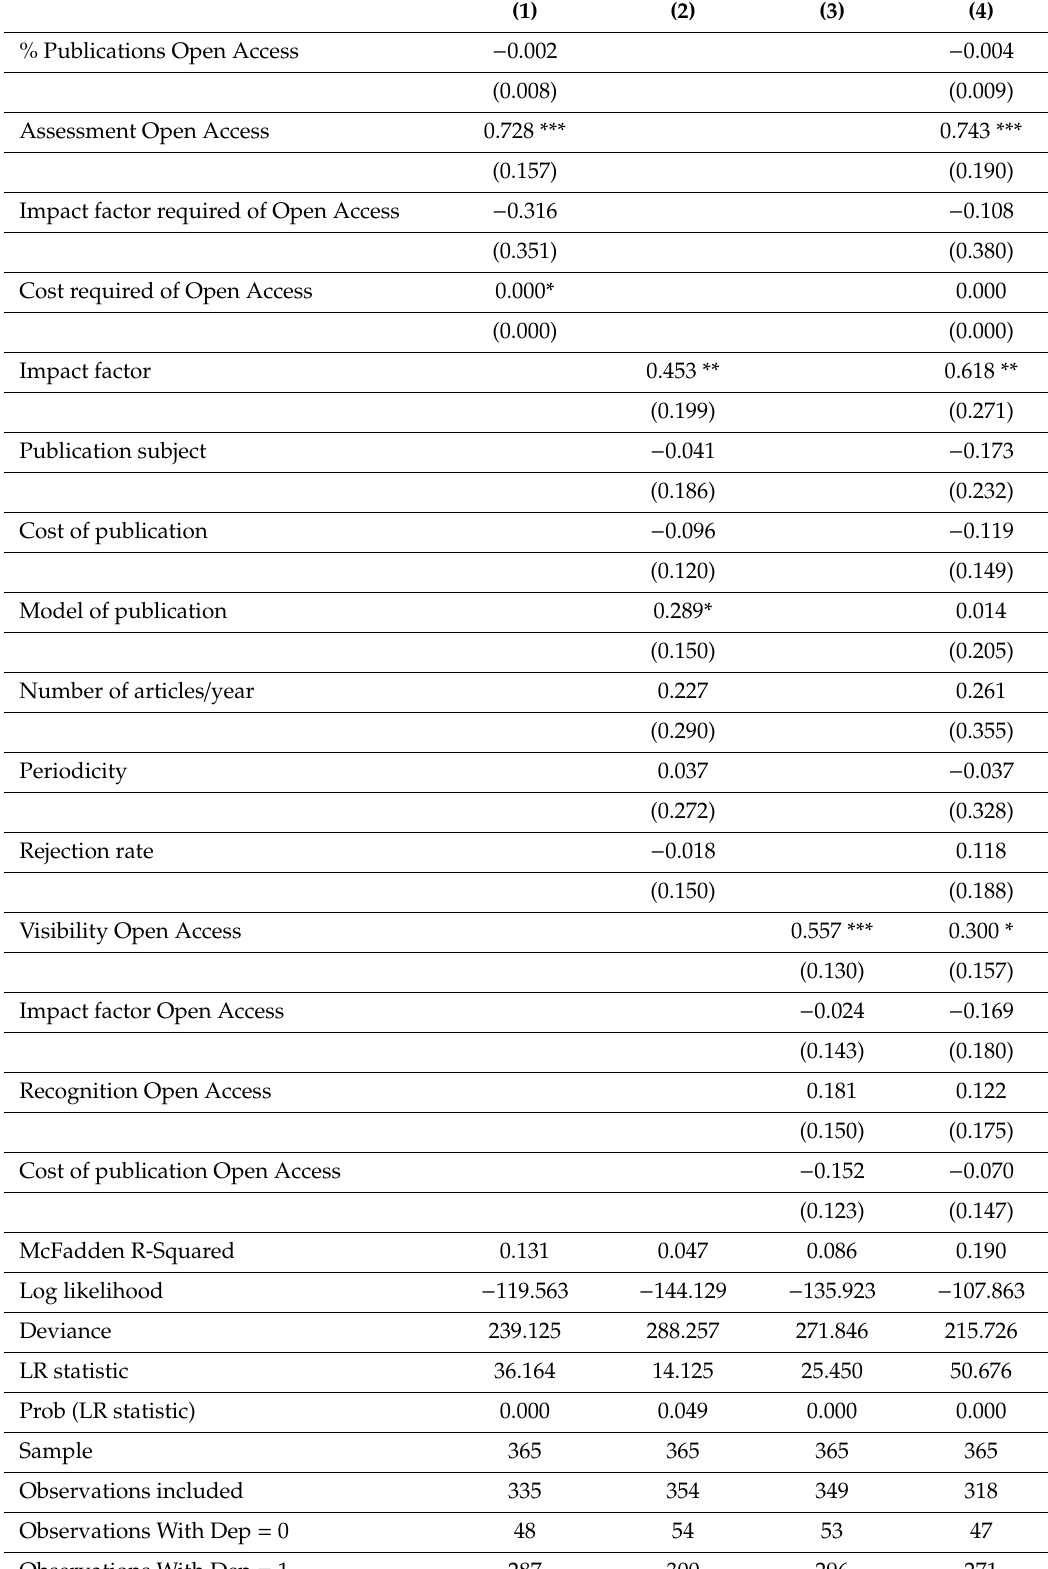
Table A3. Determinants of the future increase in Open Access publications. Logistic